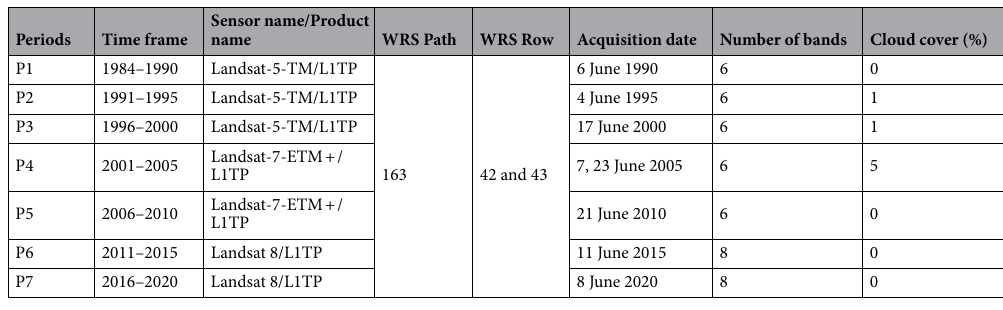
Table 1. Information on the seven periods and landsat